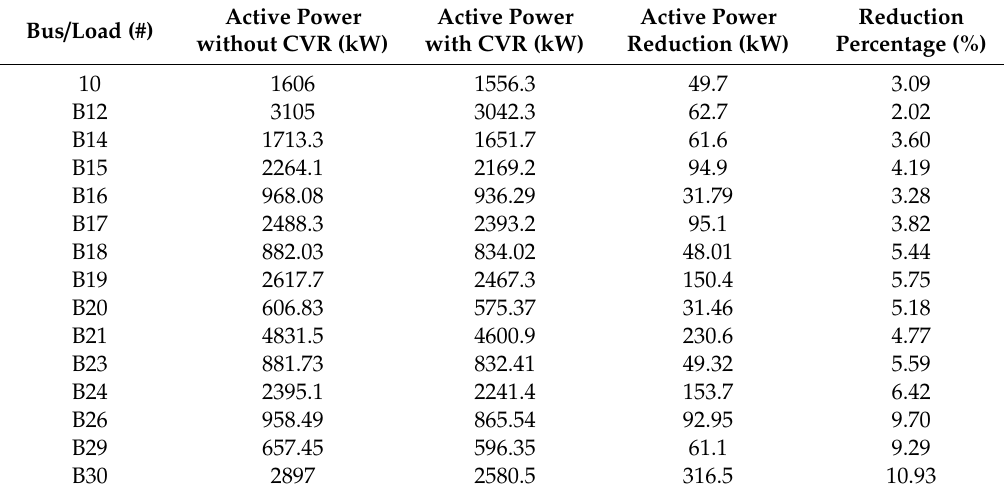
Figure 8. Case III: Comparison of the voltage profile without CVR (Base case) and with CVR. Table 2. Case III: Active power with/without CVR.